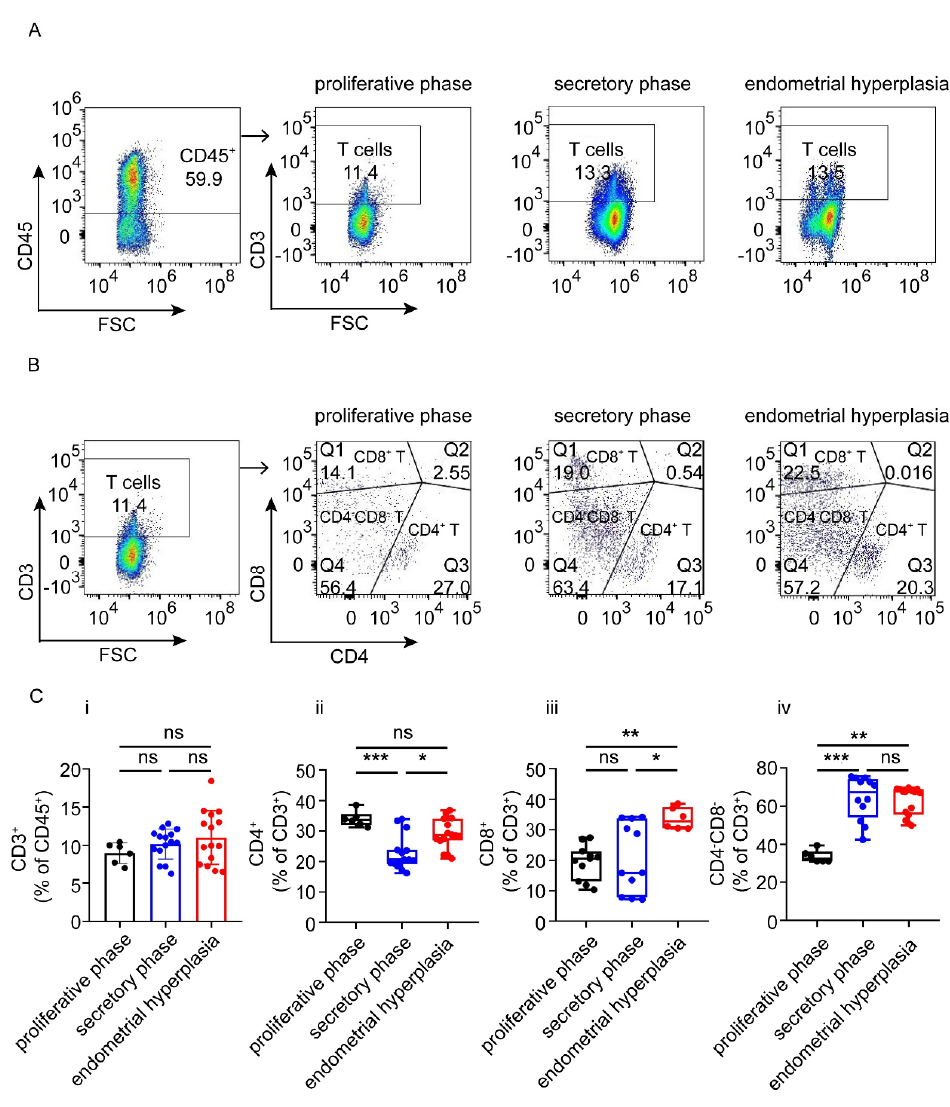
Figure 3. Different subtypes of T cells in proliferative phase, secretory phase and endometrial hyperplasia endometrium of AUB patients. ( A ) CD45 + gate, followed by CD3 + gate, was used to distinguish T cells. ( B ) Gating strategy was used to distinguish CD4 + T cells, CD8 + T cells and CD4 − CD8 − T cells. ( C ) Graph shows the proportion of total T cells, CD4 + T cells, CD8 + T cells and CD4 − CD8 − T cells in proliferative phase, secretory phase endometrium and endometrial hyperplasia endometrium of AUB patients. Data are presented as the mean ± standard error of the mean ( C.i ), or the median and the interquartile range ( C.ii – C.iv ). Statistical significance (one-way ANOVA with a Bonferroni multiple-comparisons test ( C.i ) or Kruskal–Wallis test with Dunn’s multiple- comparisons test ( C.ii – C.iv )):,* p < 0.05, ** p < 0.01, *** p < 0.001, ns, no significant difference. Subsequently, we found that the patients in the proliferative phase had higher numbers of CD3 + CD56 − NK cells than patients in the secretory phase ( p < 0.01) and EH groups ( p < 0.0001) (Figure 4A,B), and the patients in the secretory phase group had the lowest populations of CD3 + CD56 + NKT cells in the endometrium ( p < 0.001 , p <0.01) (Figure 4A,B).